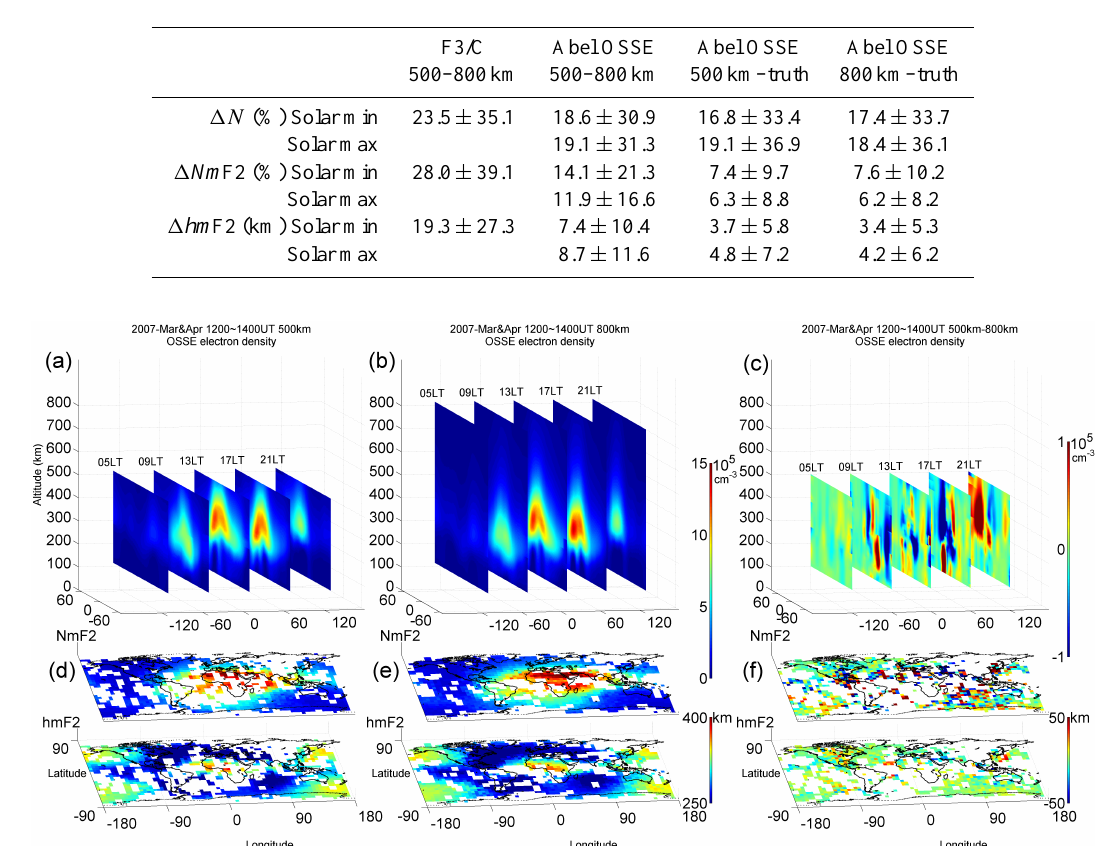
Table 1. The differences of N , Nm F2, and hm F2 observed at 500 and 800km altitude.